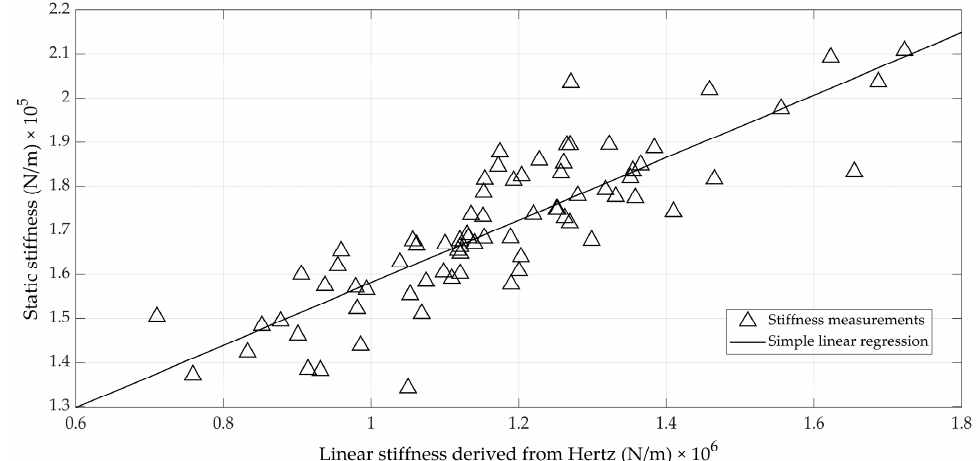
Figure 9. Scatterplot of the static stiffness measured during quasi-static compression using a Universal Test Machine as a function of the linear stiffness derived from Hertz theory.